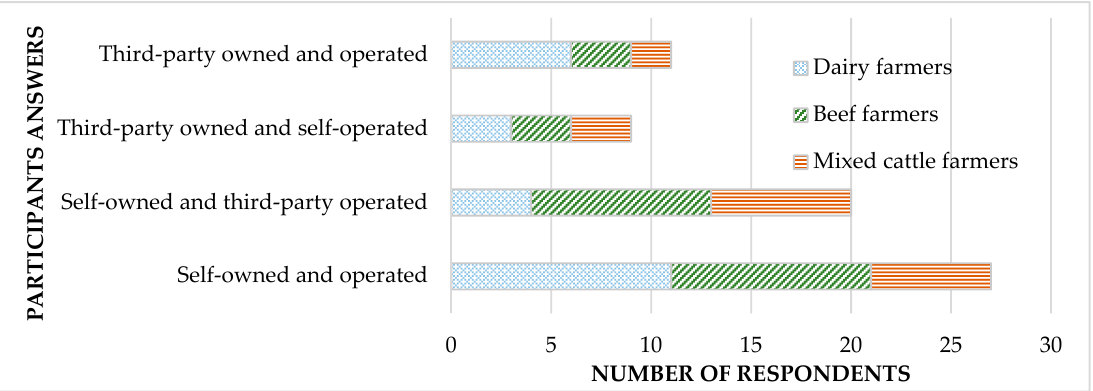
Figure 3. Survey responses preferred AD plant operating conditions.